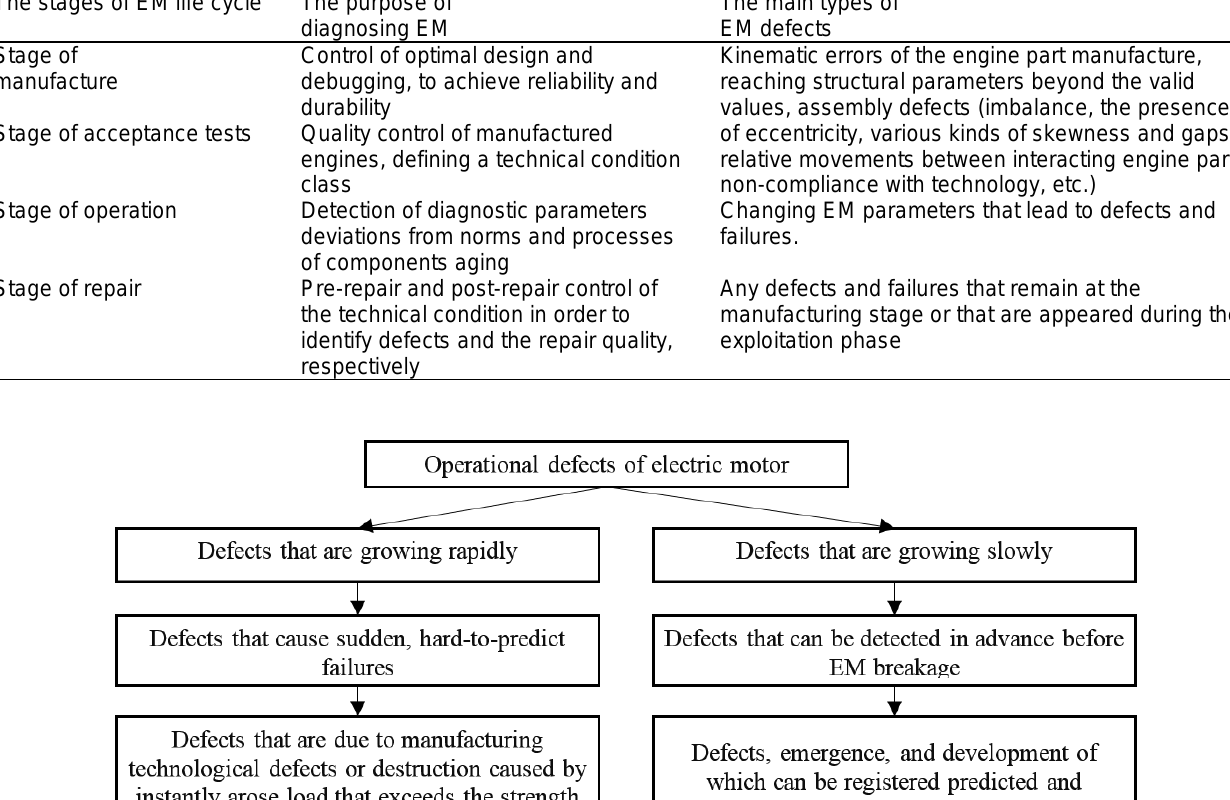
Table 1. Stages of diagnosing electric motors quality evaluation